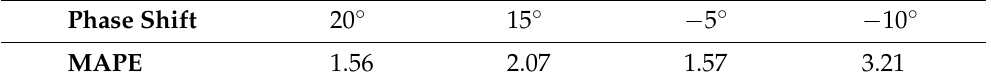
Table 7. Results of the approximation of the active power flows with the presence of a PST.